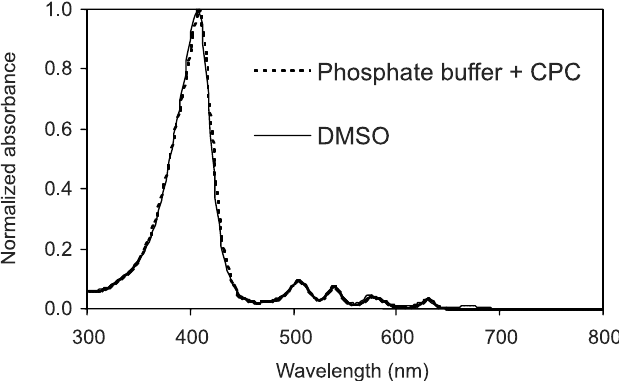
FIGURE 1 - Normalized absorption spectra of PpIX (2.0 μg/mL) in the solvents used for the in vitro penetration studies.